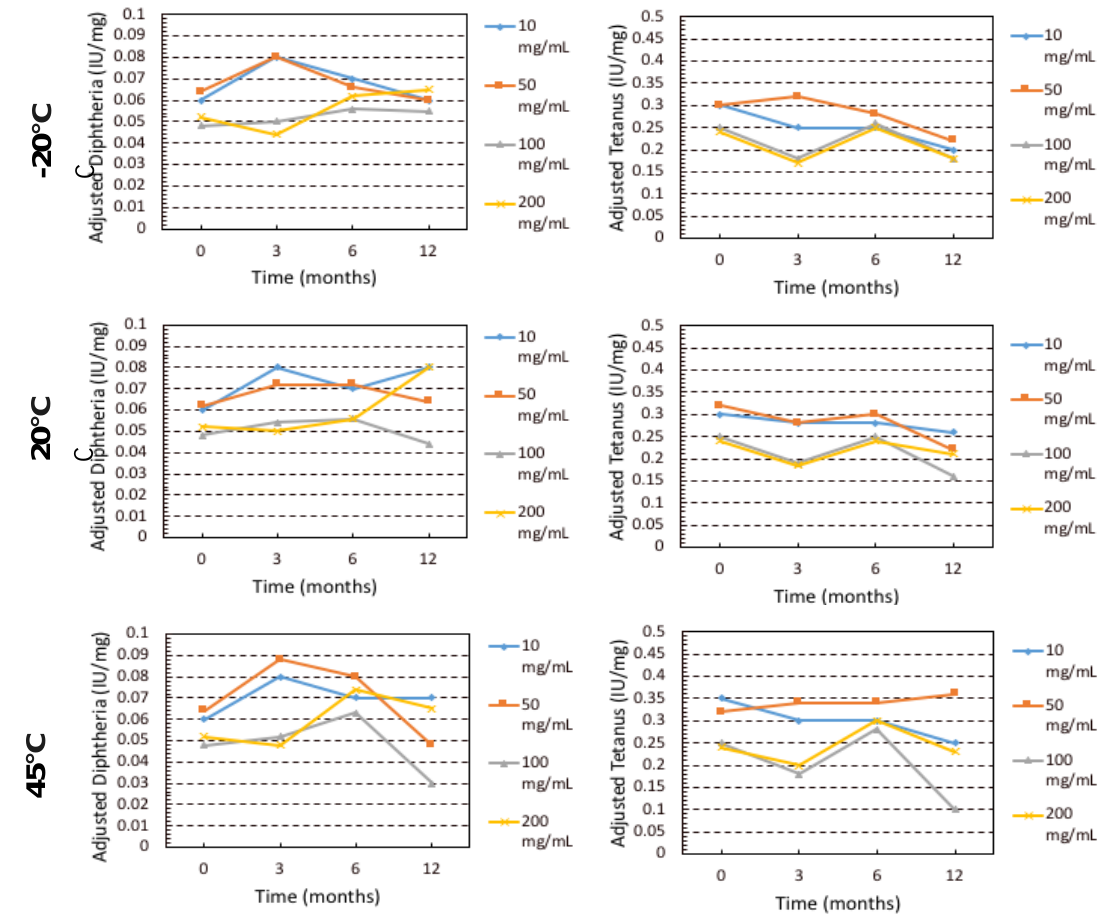
Figure 3. ELISA Diphtheria and Tetanus normalized binding activity (IU/mg) for IgG over the course of 12 months stored at −20 °C, 20 °C and 45 °C.